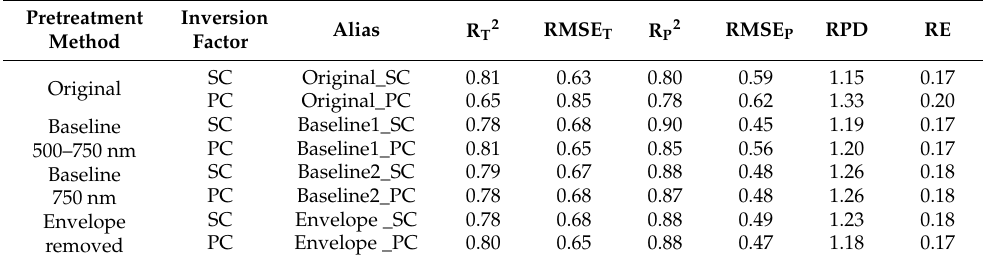
Table 2. Inversion results of the combined model.